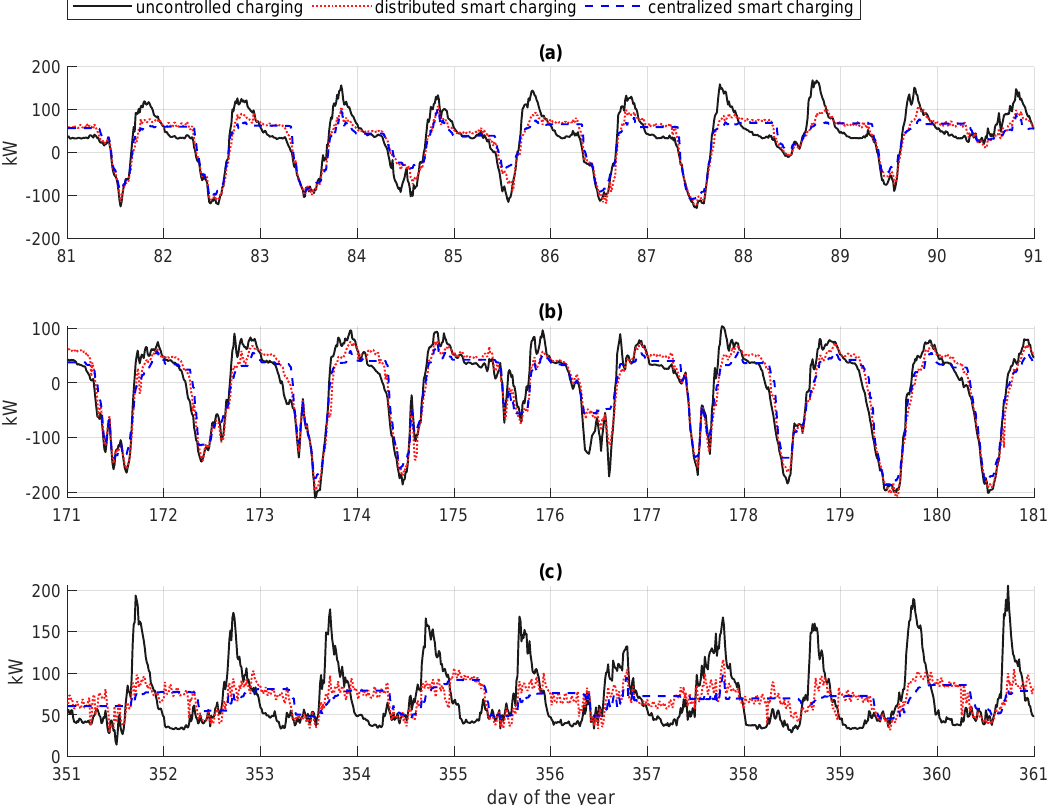
Figure 6. Net-load profile of the aggregation of 100 households with R = 0.5 in ( a ) spring, ( b ) summer, and ( c ) winter.